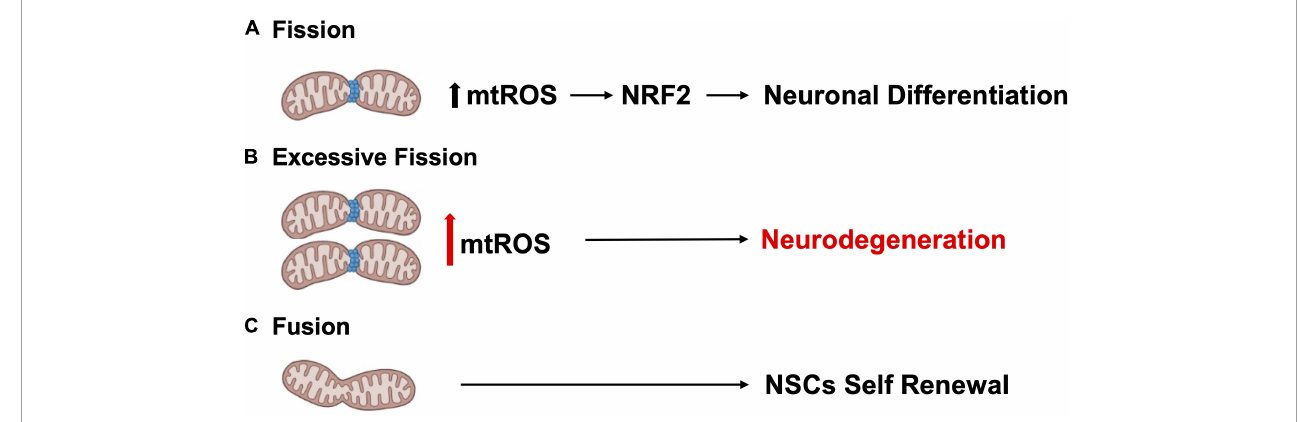
FIGURE2 Mitochondrial dynamics regulate neurogenesis. (A) Mitochondrial fission promotes neuronal differentiation. (B) Excessive fission and ROS production contributes to neurodegeneration. (C) Enhanced mitochondrial fusion promotes NSCs self-renewal.